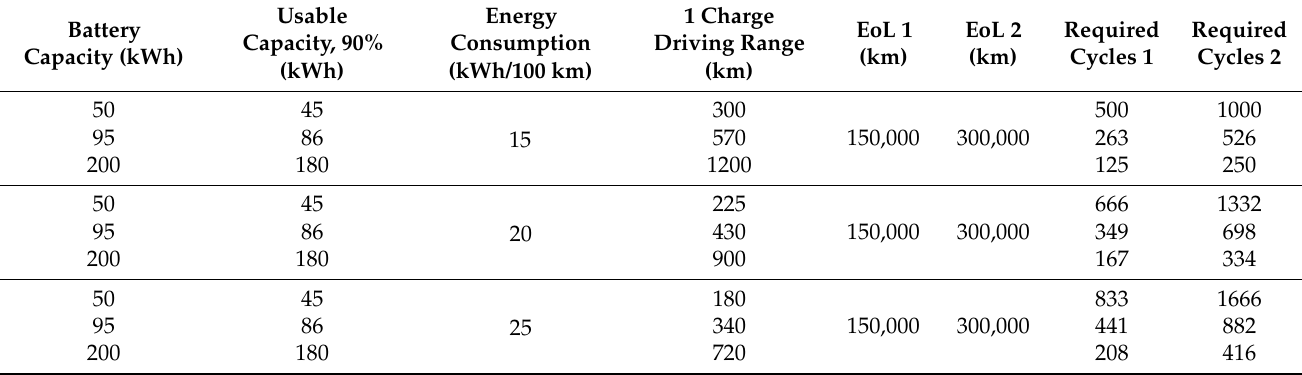
Table 4. Theoretical calculations of EoL cycles for different EV types.